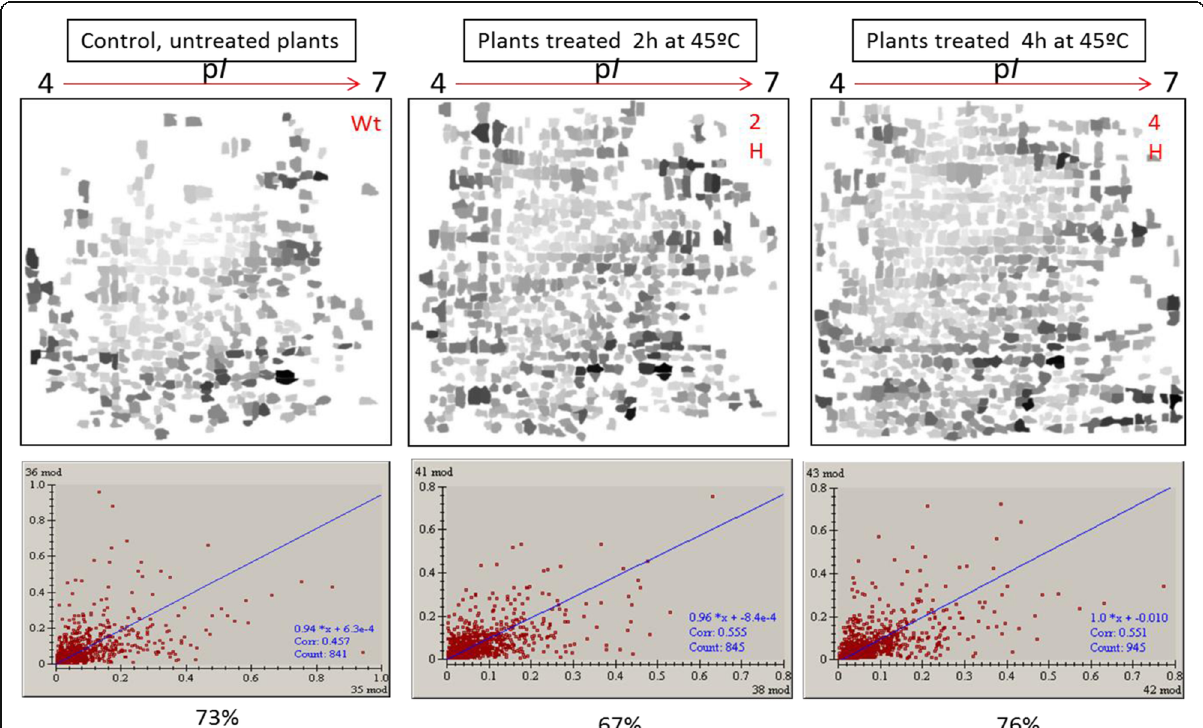
Fig. 2 The correlation between the three gel replicates of each treatment. The merge between the three replicates of untreated plants (control) was 73%, for the treated plants at 45 °C for 2 h was 67%, while 76% was shown at 45 °C for 4 h